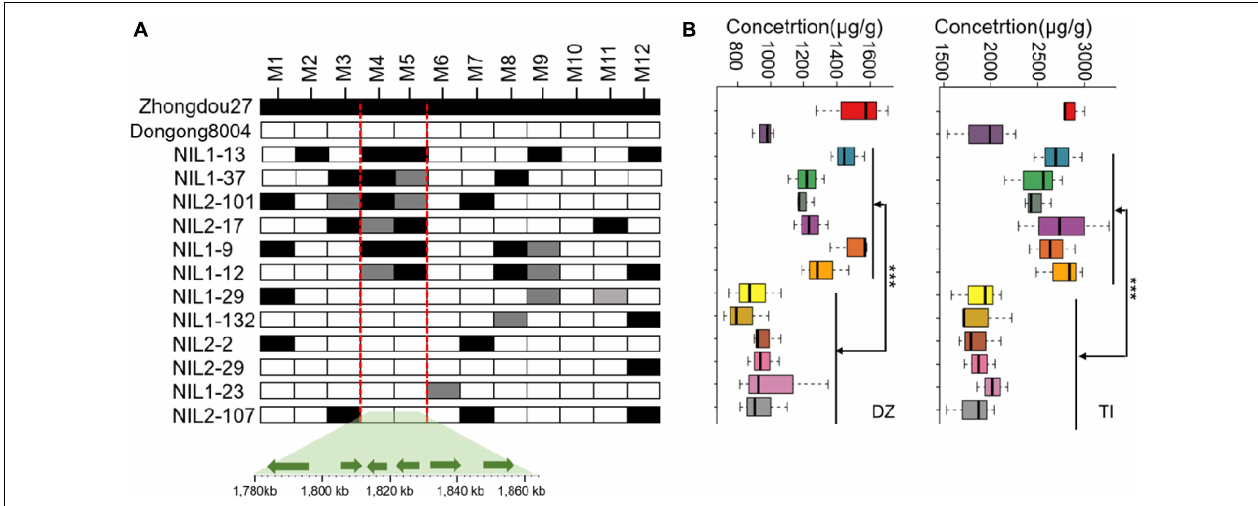
FIGURE 2 | Refinement of the qISO19-1 region. (A) Restriction of qISO19-1 to a 62.8-kb region of chromosome 19 in the RIL population, and identification of recombinants based on 12 polymorphic markers. Black cells indicate alleles homozygous with the male parent (“Zhongdou27”); white cells indicate alleles homozygous with the female parent (“Dongnong8004”); gray cells indicate heterozygous alleles. Below are shown the positions of the six candidate genes in the qISO19-1 region, as indicated by comparisons to the reference genome. (B) Contents of daidzein (DZ) and total isoflavone (TI) in seeds produced by the recombinant lines. *** P <